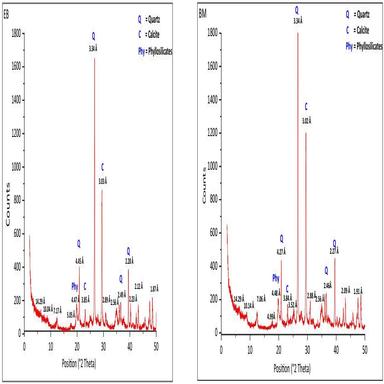
X-Rays diffraction of the three bulk samples: EB. BM and BS.